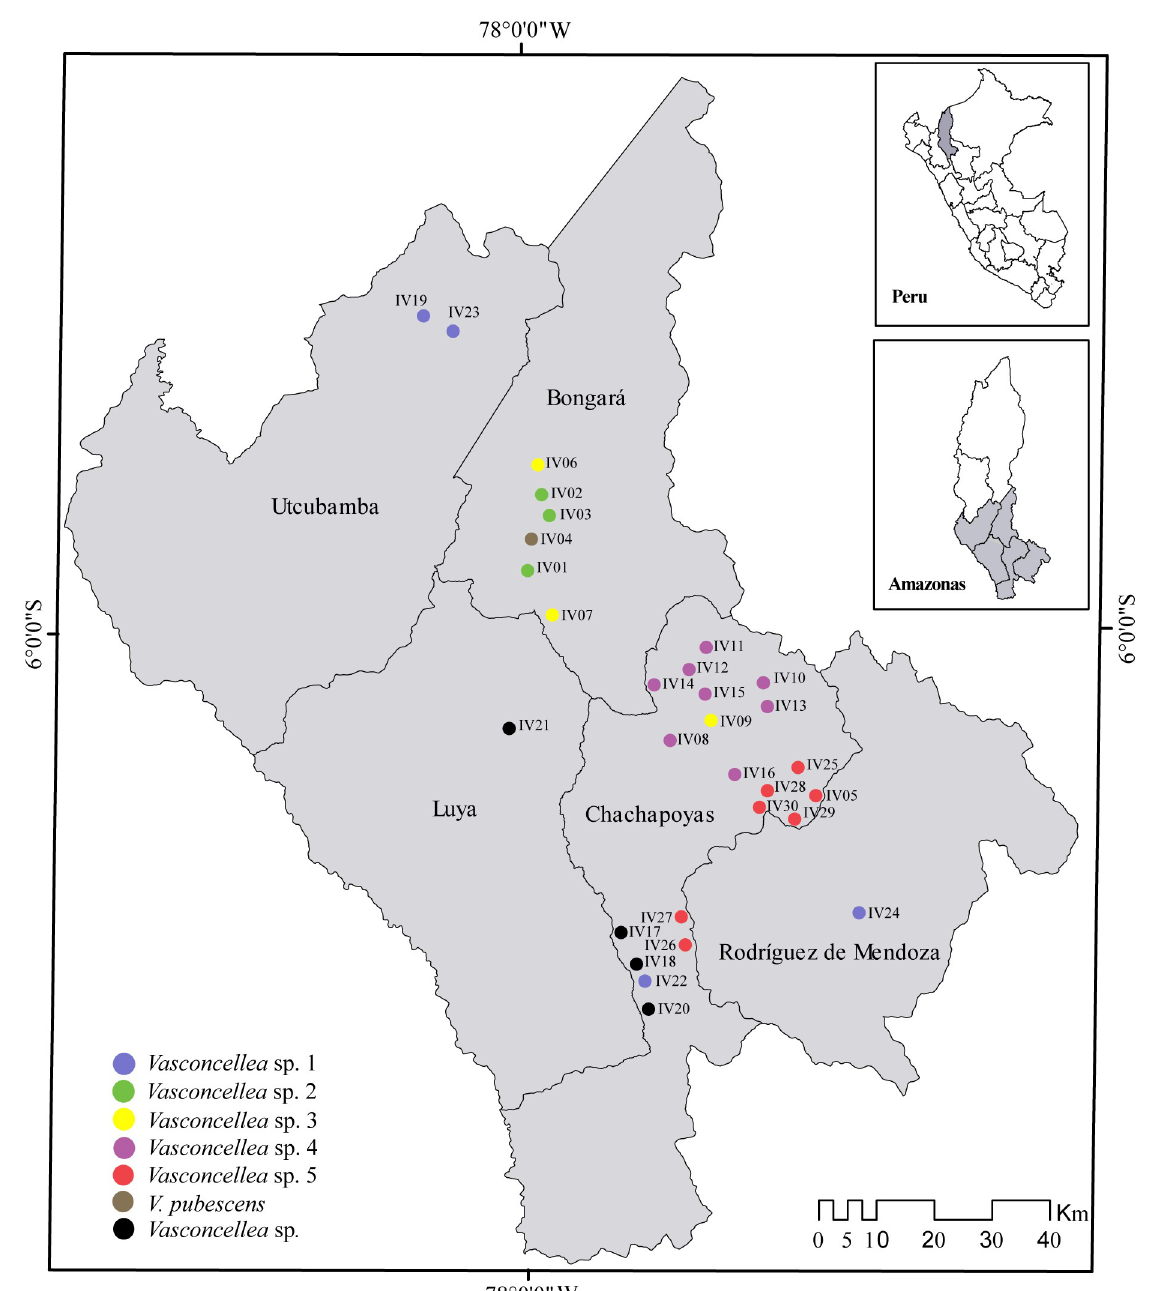
Fig 1. Collections of the 30 specimens of the genus Vasconcellea from the Region Amazonas, northern Peru. The national, provincial and district boundaries were obtained from the Geoportal of the National Geographic Institute of Peru (IGN) in shapefile format with a DATUM WGS 1984 for illustrative purposes